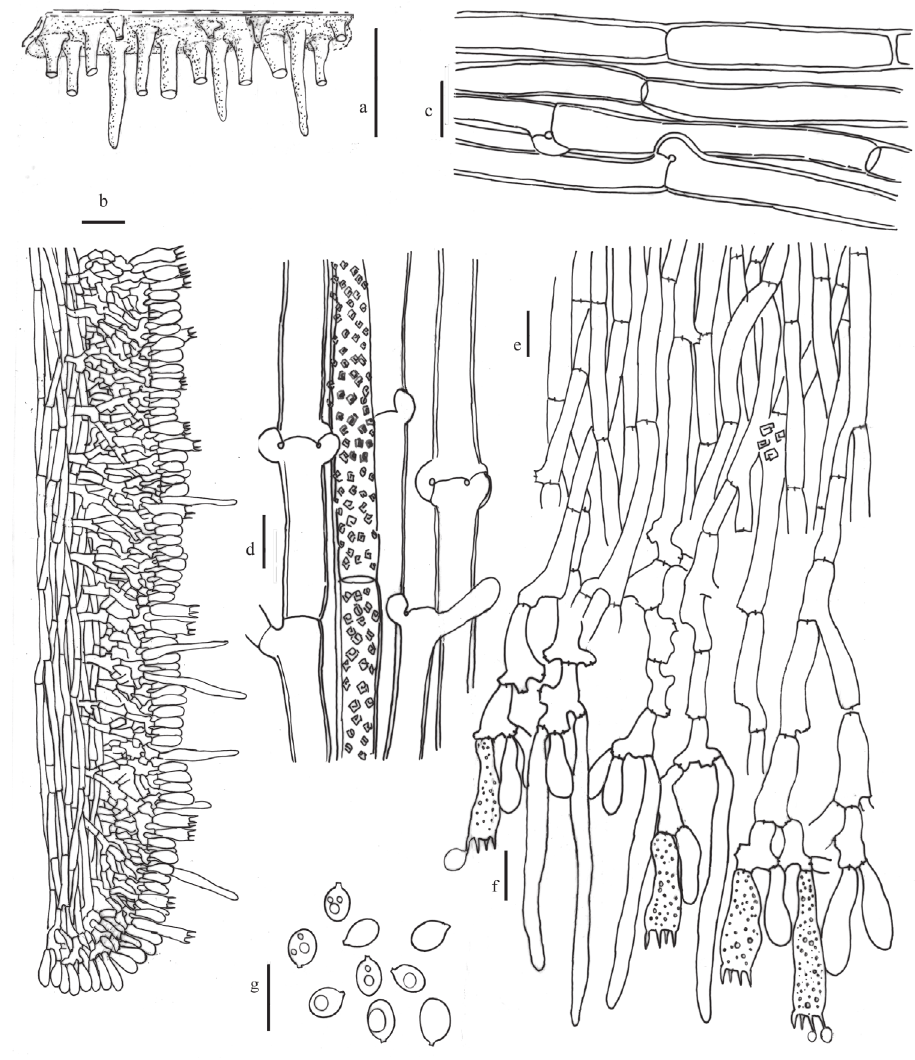
Figure 8. Hydnophlebia meloi. Collection 19071Tell., MA-Fungi 86654, holotype a Hymenophore b Vertical section through an aculei c Subicular hyphae d Strand hyphae e Aculei hyphae f Subhymenial hyphae, cystidia, and basidia g spores. Scale bars: a = 1 mm; b = 25 μm; c–g = 10 μm. Drawing by M.